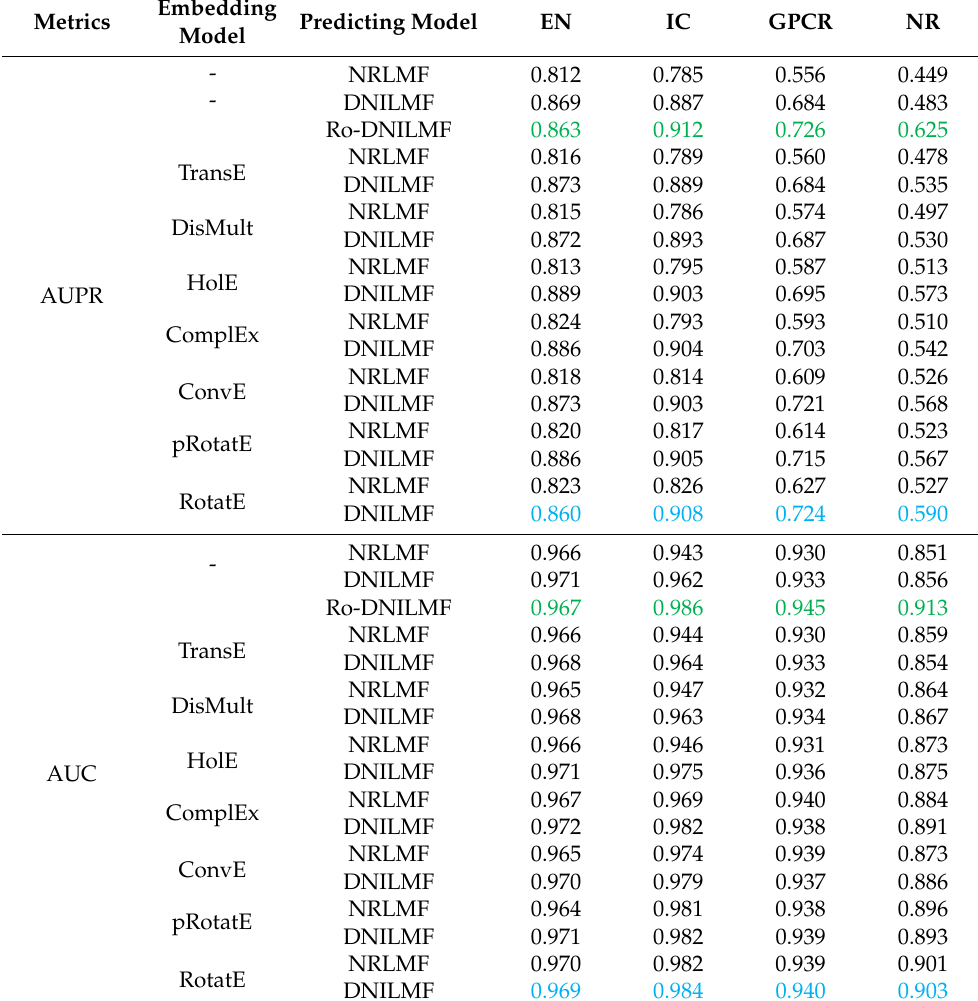
Table 4. Comparative results of the presented method and other combination